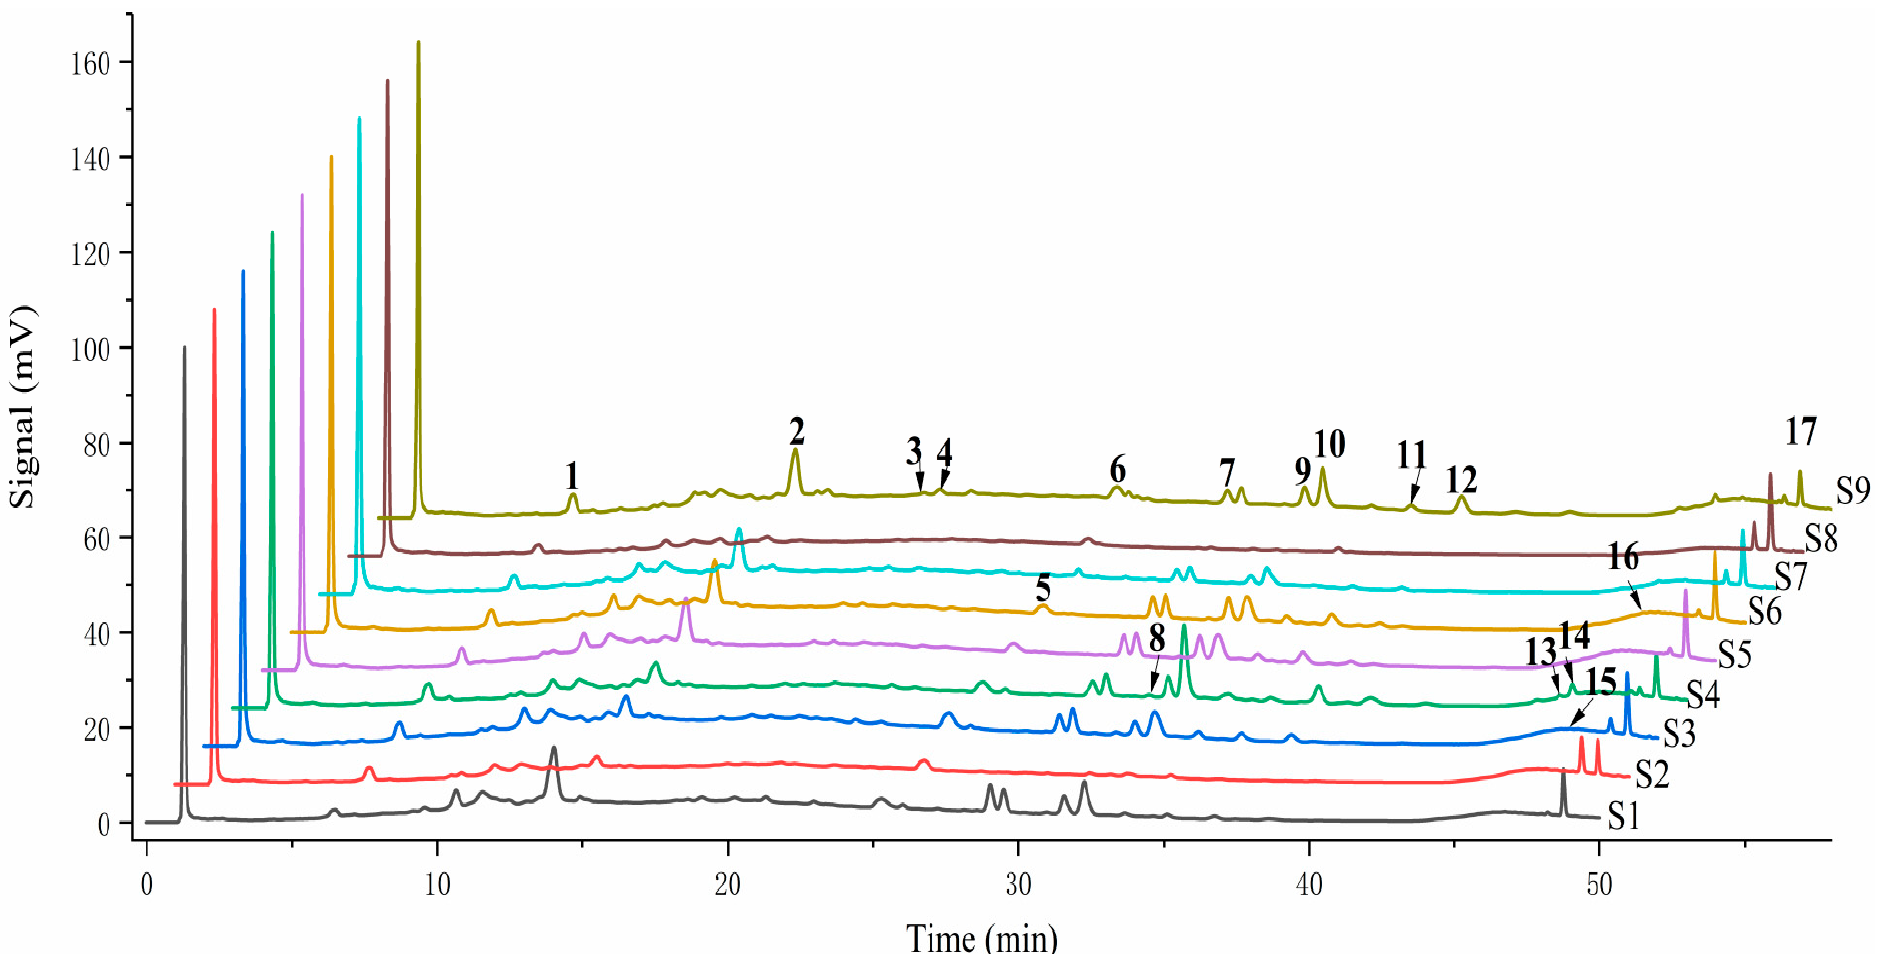
Figure 3. Flavonoids of W. japonica from different habitats (Sample sites shown in Table S1, in Supplementary Materials).